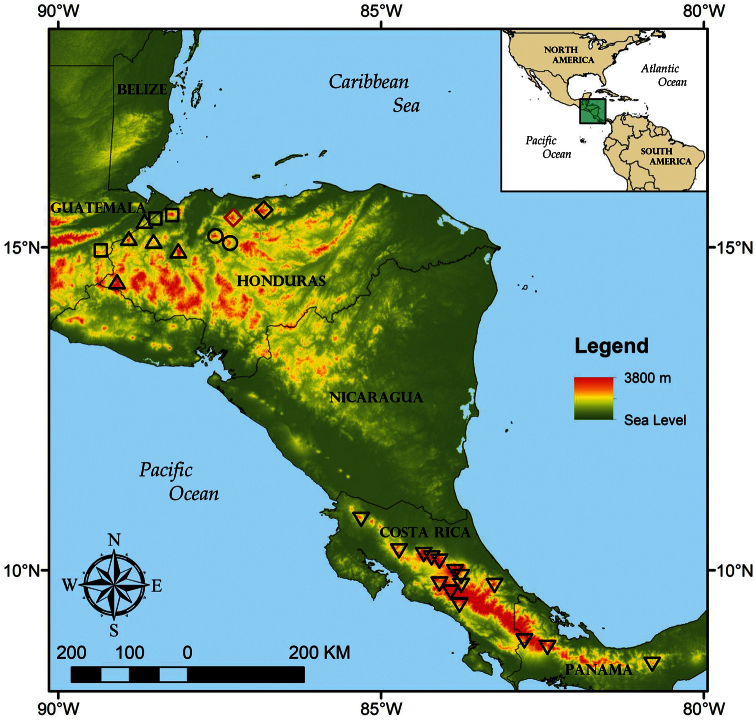
Geographic distribution of selected Bothriechis species and populations discussed in the text; localities are based on data published herein and those of Campbell and Lamar (2004), McCranie (2011a), and Savage (2002); red diamond = type locality of Bothriechis guifarroi in Refugio de Vida Silvestre Texíguat; black diamond = referred population of Bothriechis guifarroi from Parque Nacional Pico Bonito; circles = Bothriechis sp. inquirenda populations for the Sierra de Sulaco; squares = Bothriechis marchi; triangles = Bothriechis thalassinus, inverted triangles = Bothriechis lateralis.